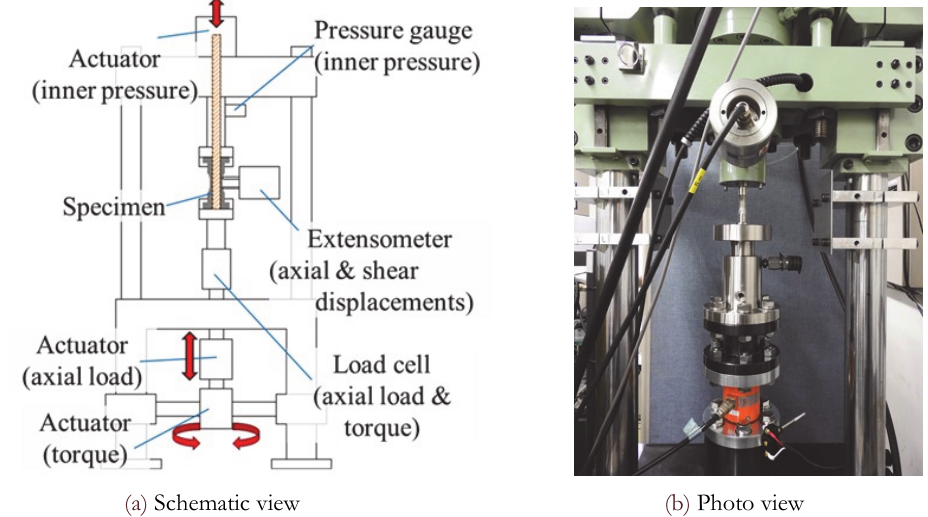
Figure 2: Multiaxial fatigue testing machine for push-pull and reversed torsion tests with inner